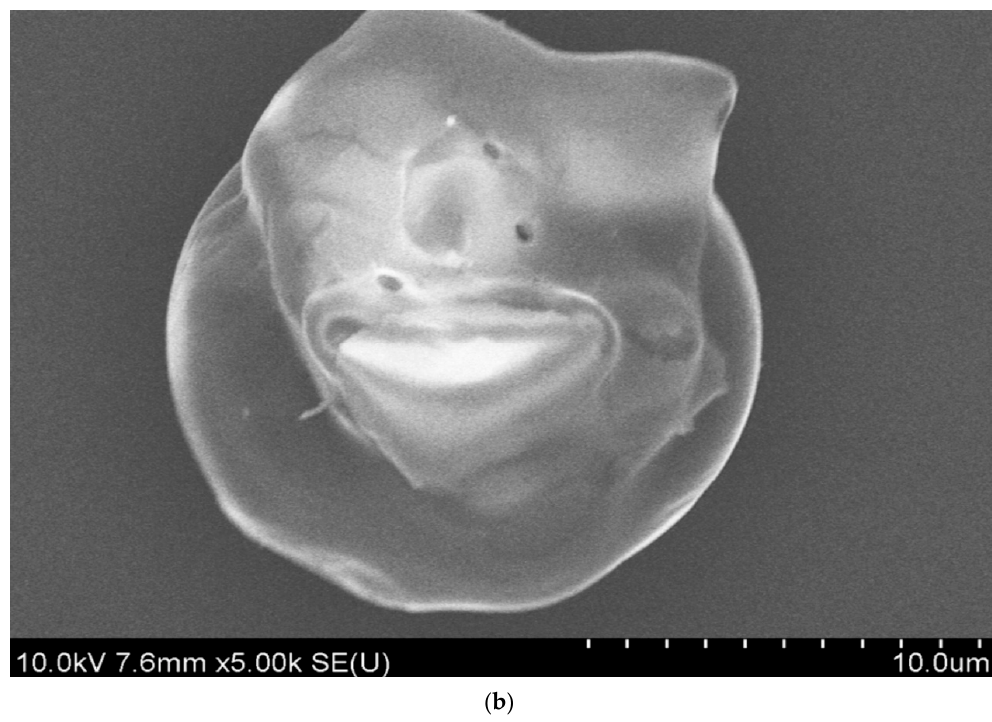
Figure 1. ( a ) Optical microscope images and ( b ) SEM (Scanning Electron Microscope) image of the PLA (polytrimethylene carbonate) microcapsules in vacuum. Reproduced with permission from [57], IDEALS, copyright 2015.